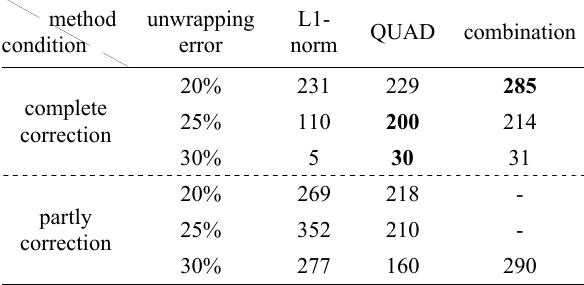
Table 1. The number of complete and partial unwrapping errors correction in the 500 simulations.